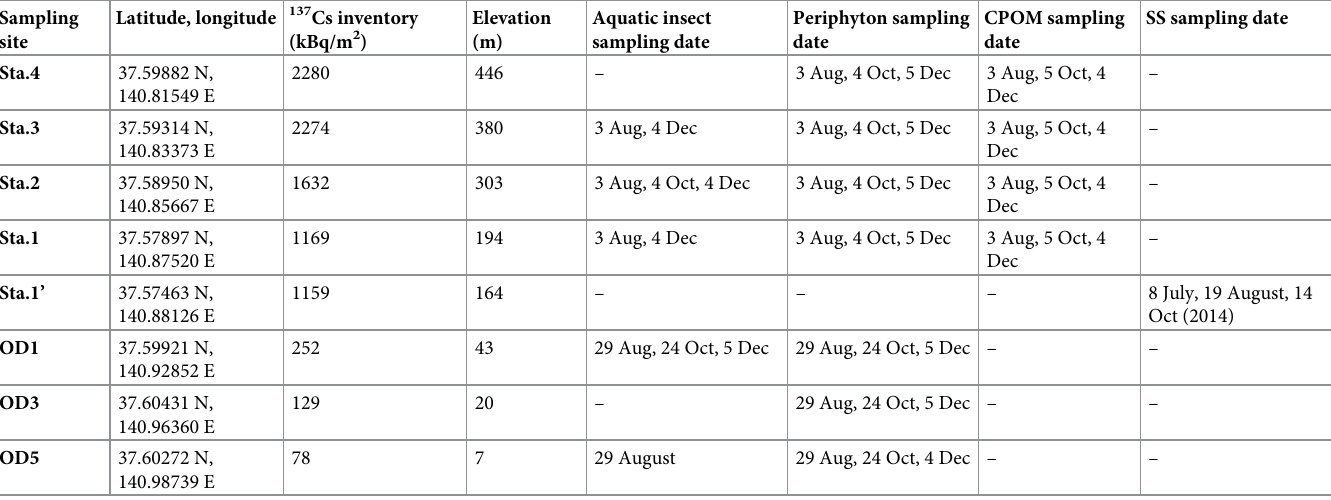
Table 1. Information of the sampling sites along Ota River. Sampling